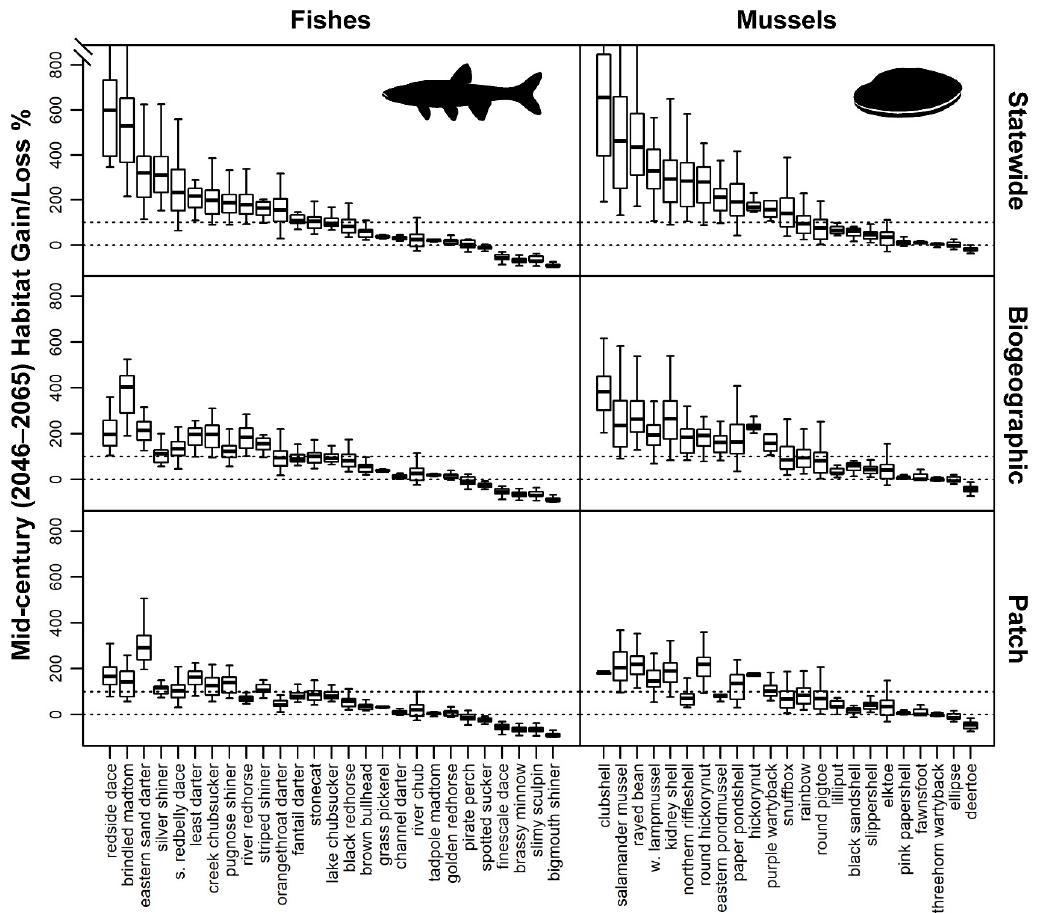
Figure 4. Percent gain/loss in highly suitable habitat relative to current predictions for 13 mid-cen- tury (2046–2065) climate change projections. Results are shown for three geographic extents: statewide, biogeographic (includes predictions only from basins with historic species occurrences), and patches (includes predictions only for patches with historic species occurrences nested within a specie’s biogeographic range), with percentages based on the amount of current suitable habitat for each respective extent.